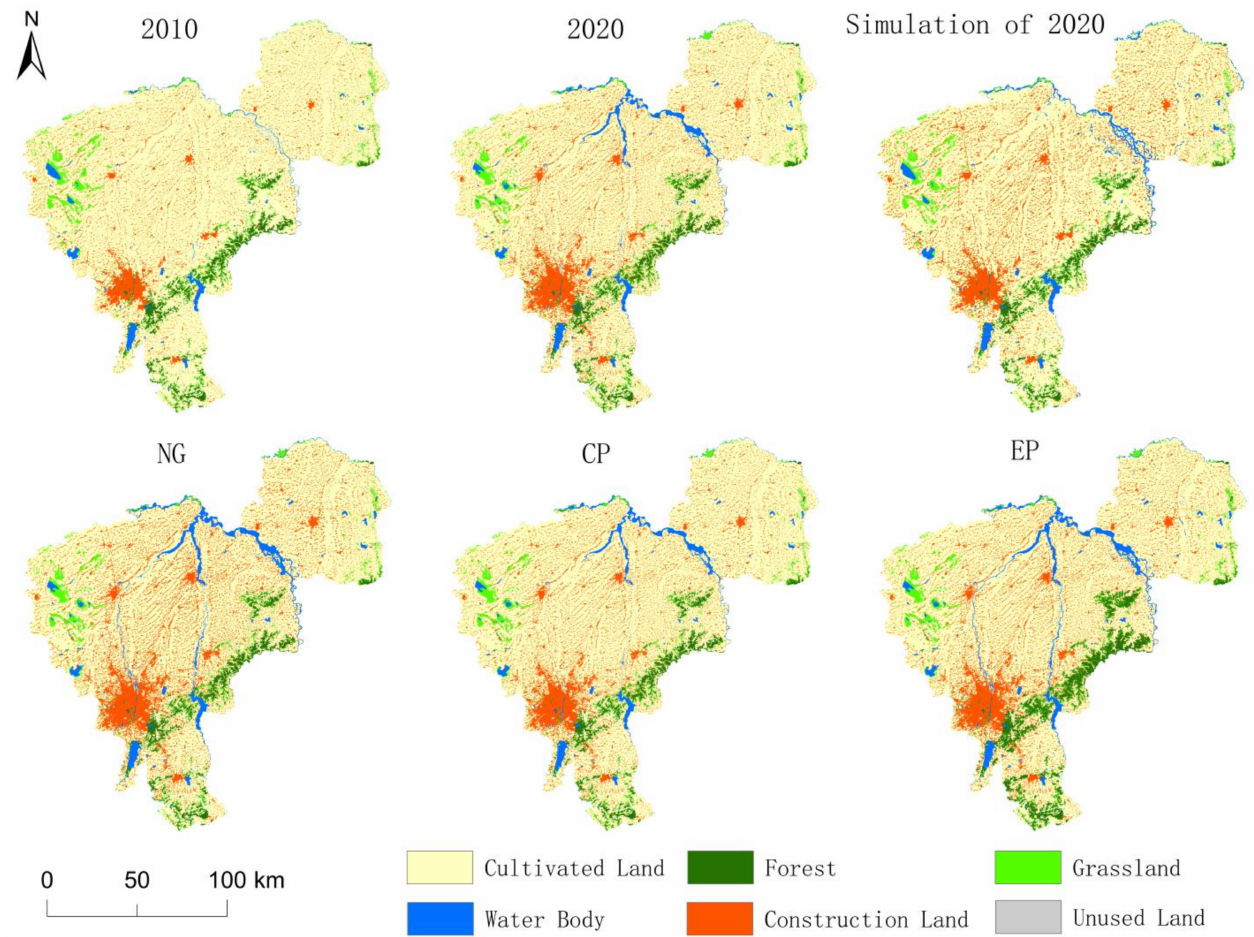
Figure 3. Land use map in 2010, 2020, simulation for 2020, and simulation under three scenarios for 2030 of